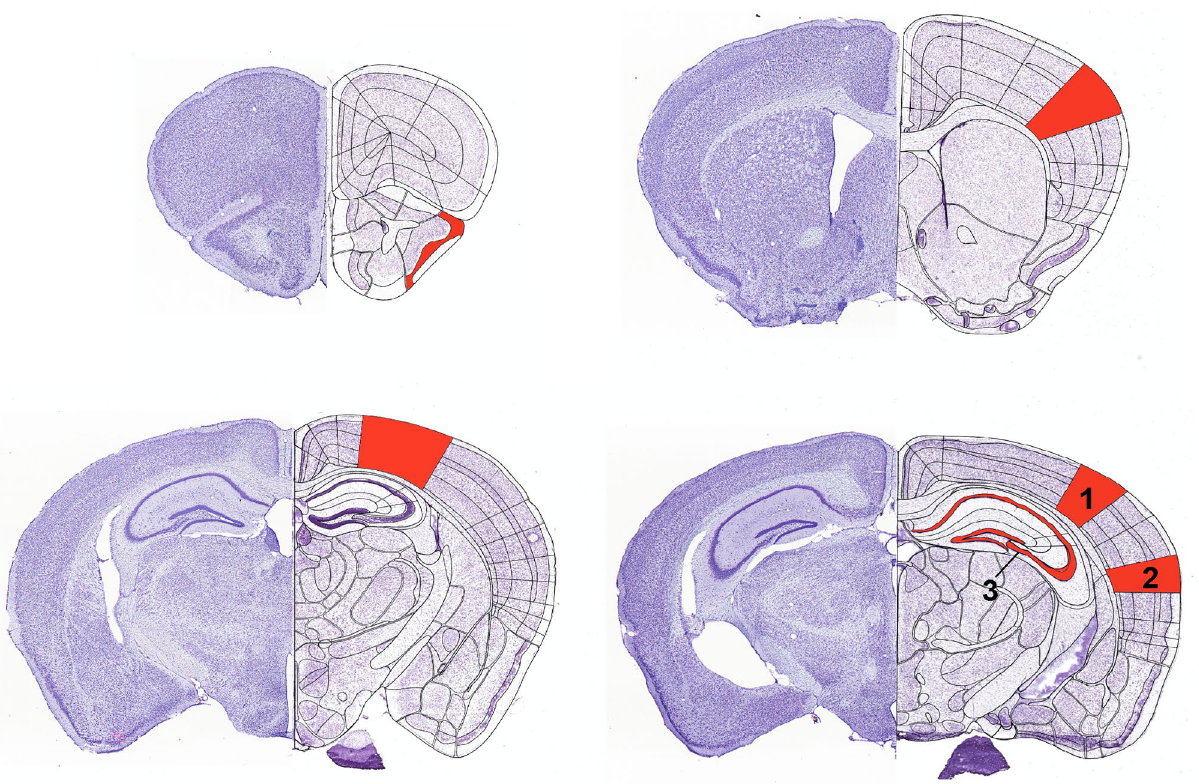
Figure 1. Diagram of areas selected for immunohistochemical analysis. The areas assessed in the mouse cerebral cortex and hippocampus are shown in the cresyl violet-stained histological sections (left side of each example). The specific regions examined are indicated in the schemas on the right side of each example (modified from the Allen Mouse Brain Atlas (mouse.brain-map.org) and the Allen Reference Atlas—Mouse Brain (atlas.brain-map.org) 50–55 ). Markings in red represent the following areas: Top left: piriform cortex. Top right: somatosensory cortex. Bottom left: posterior parietal cortex. Bottom right: visual cortex (1), auditory cortex (2) and hippocampus (3) including the dentate gyrus, and cornus ammonis subregions